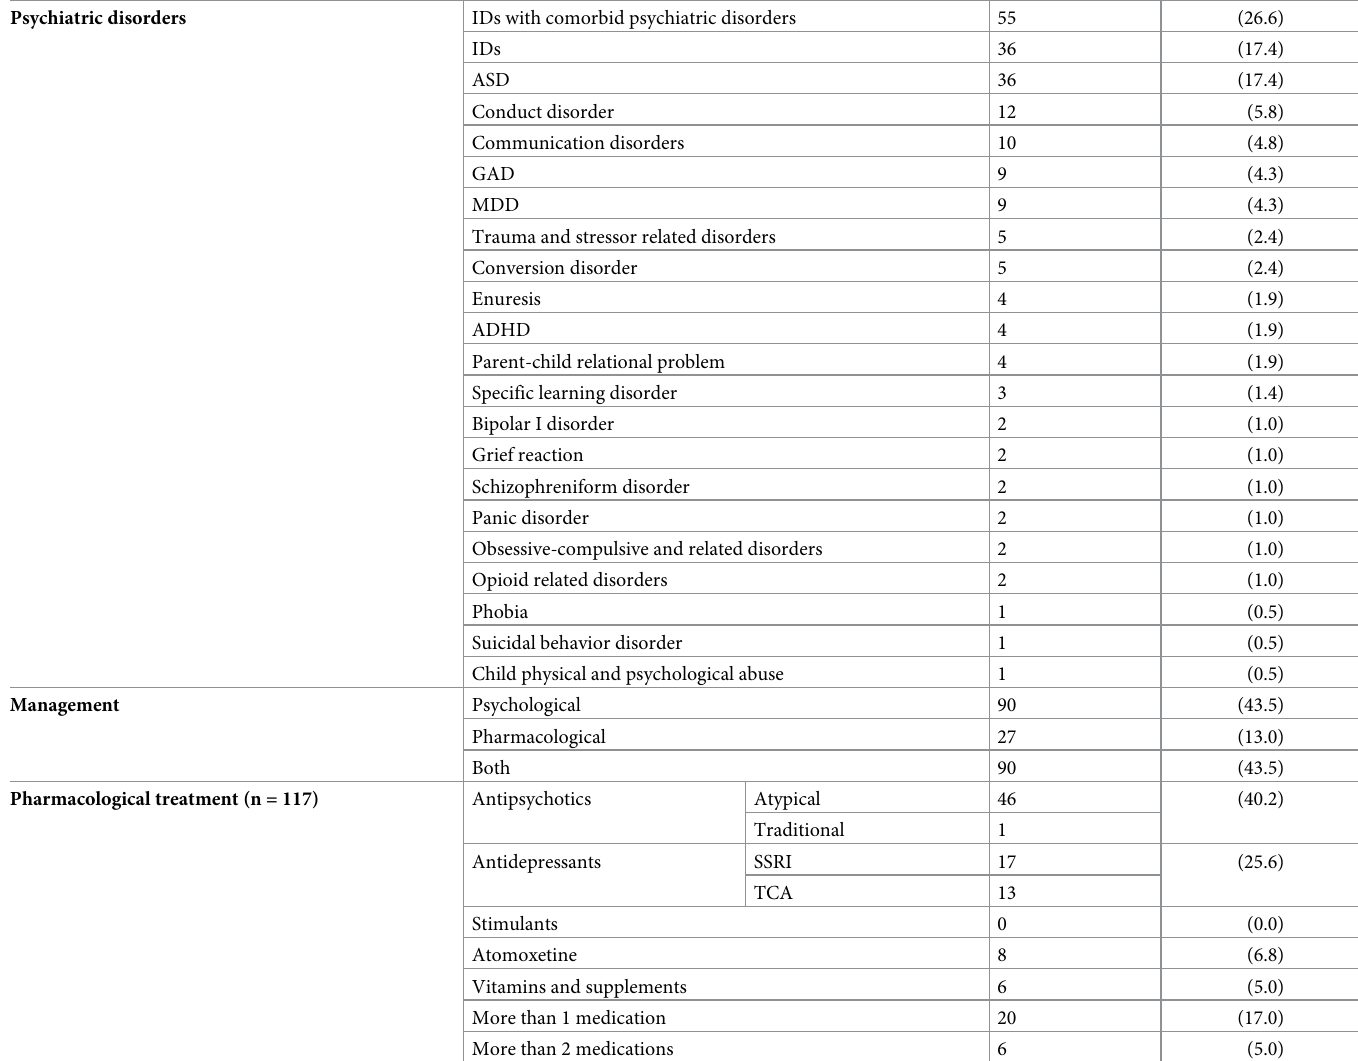
Table 5. Diagnosis and treatment